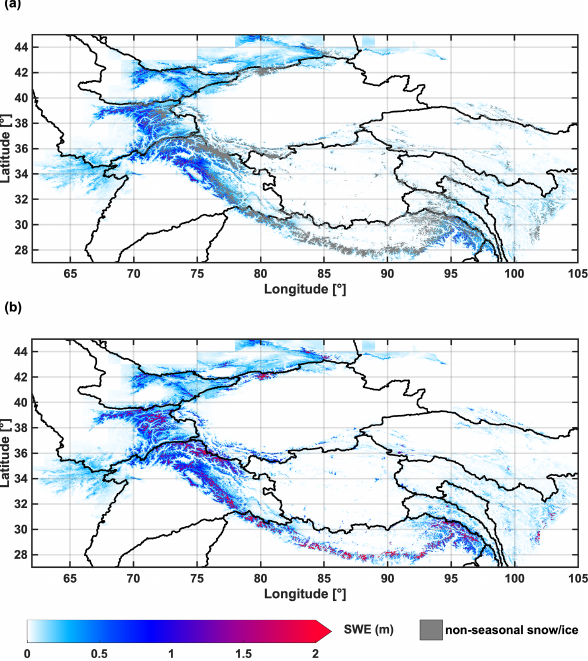
Figure 3. (a) Map of pixel-wise peak seasonal SWE climatology, with non-seasonal snow and ice pixels masked out (gray). (b) Map of pixel-wise peak seasonal SWE climatology, without masking of non-seasonal snow and ice pixels for